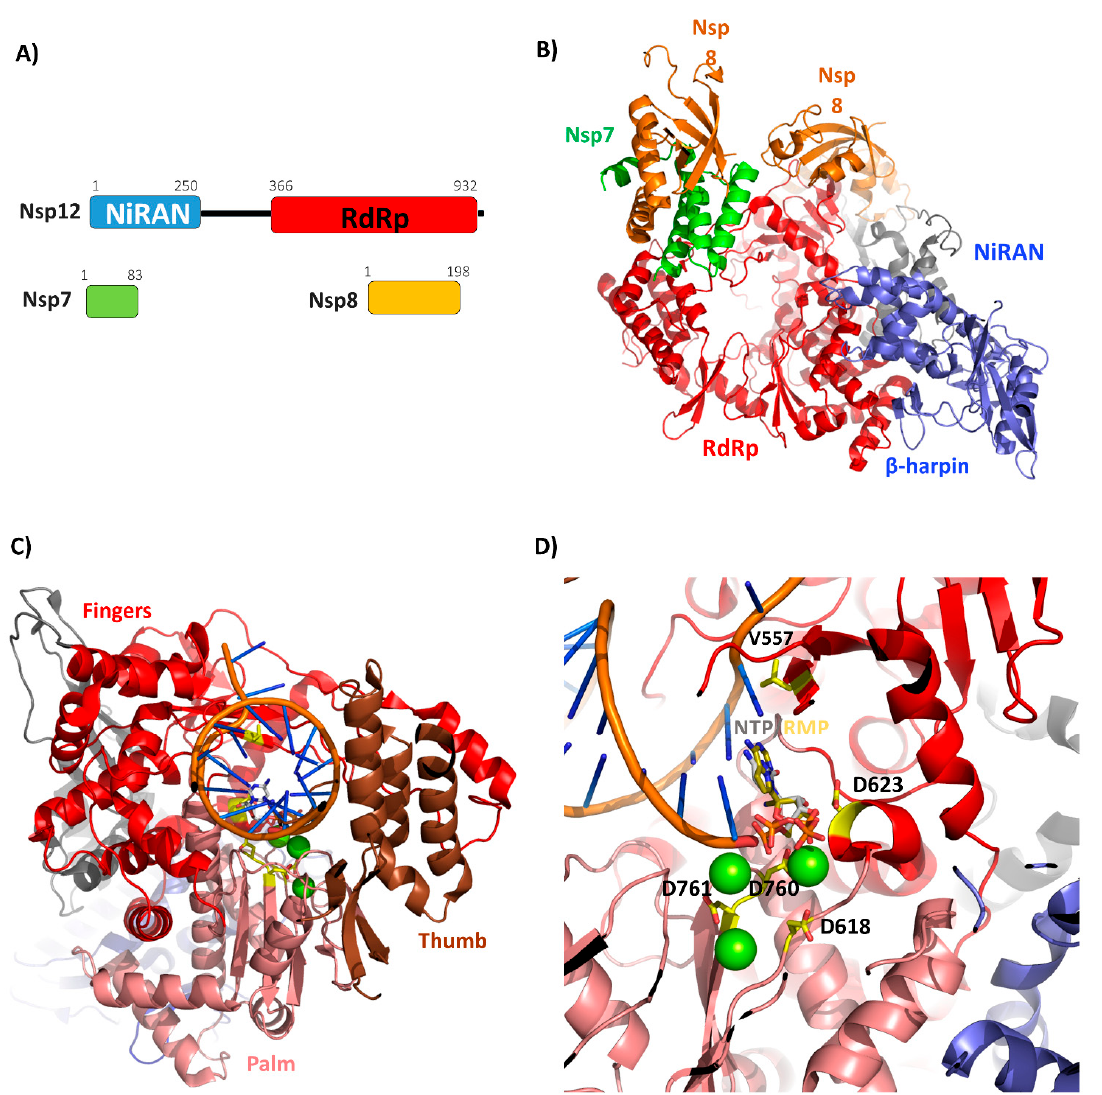
Figure 3. SARS-CoV-2 Nsp12-Nsp7-8 complex. ( A ) Domain organization of Nsp12, with its Nsp7